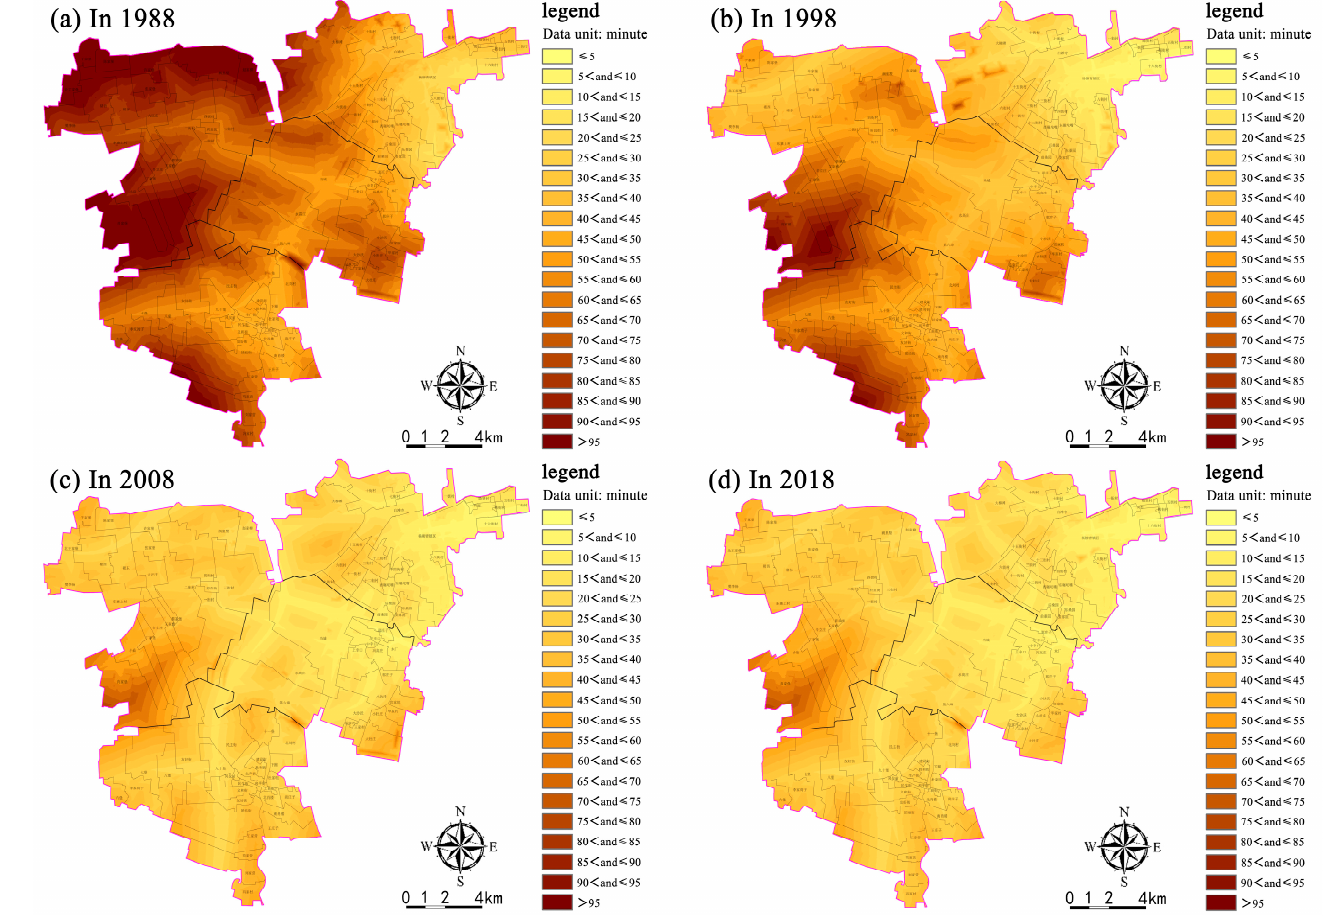
Figure 5. Change in rural accessibility to urban areas in the western suburbs of Tianjin during various periods of urban expansion (source: self-drawn).